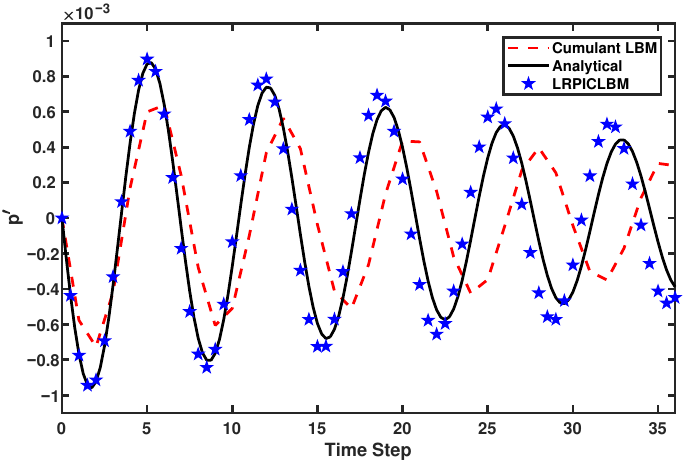
∆ x 2 ∆ t ) with N ppw = 4